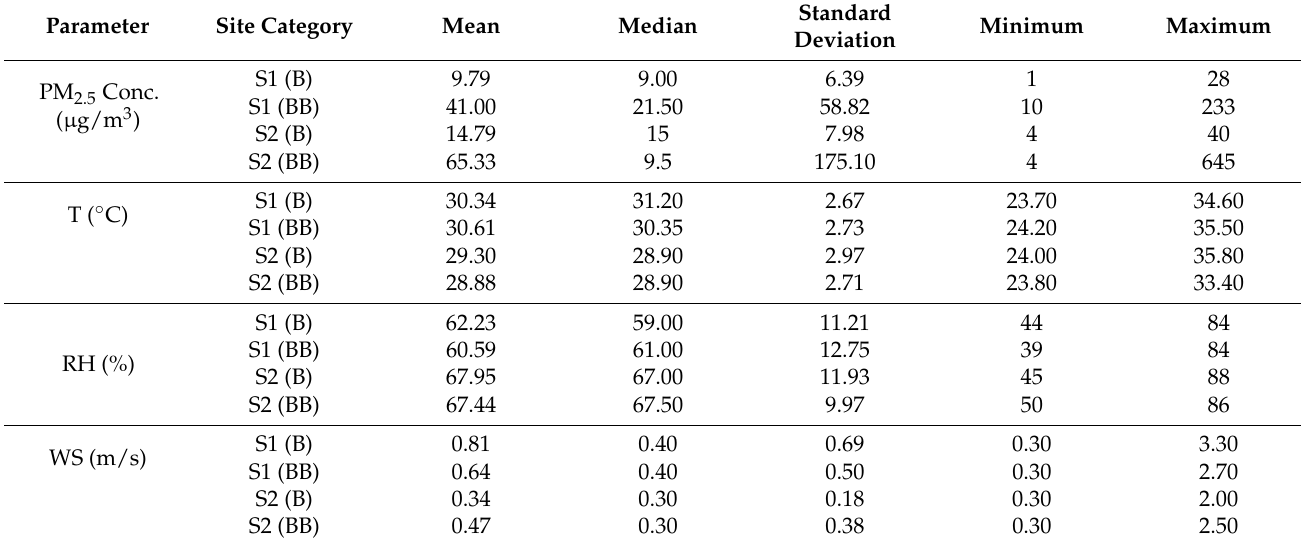
Standard Minimum Maximum Deviation